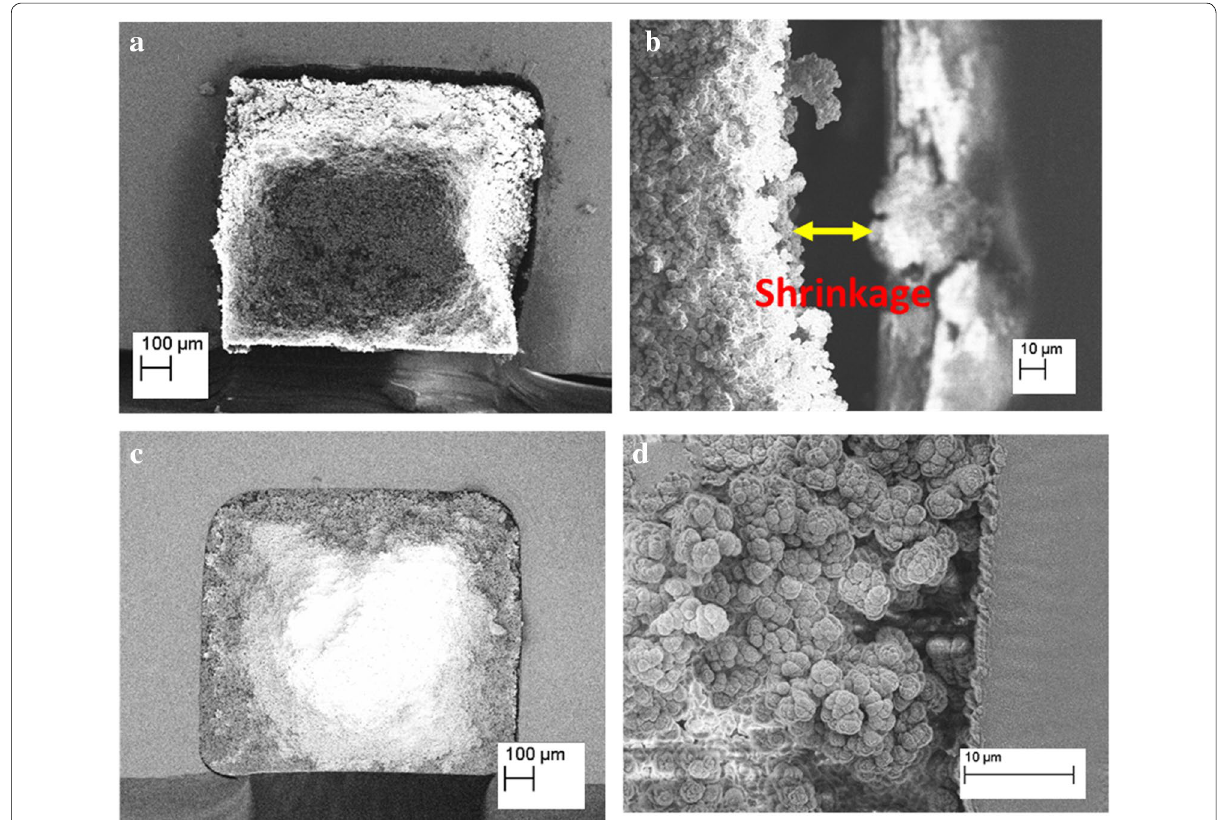
Fig. 3 The poly(methyl acrylate) monolith a without and b with the grafting layer